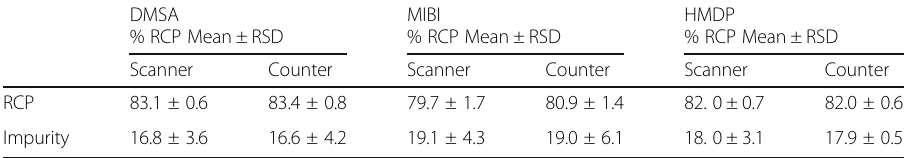
Table 2 Repeatability precision of the proposed method for the 3